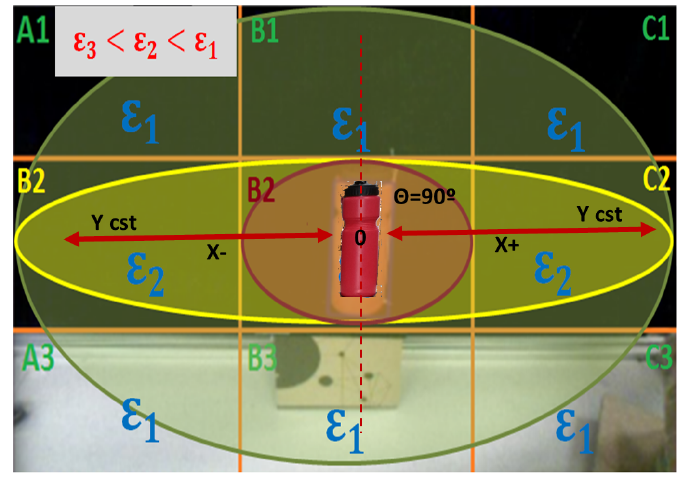
Figure 13. First